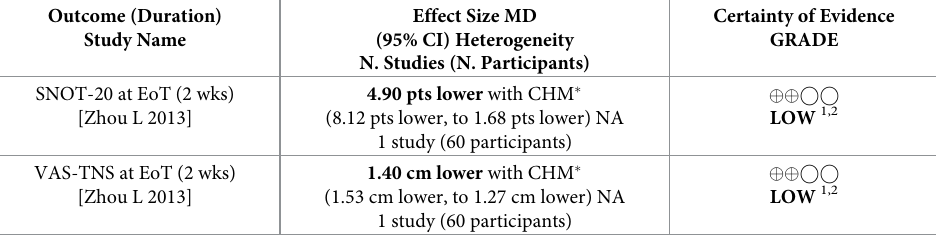
Table 3. GRADE for oral Chinese herbal medicine versus placebo for chronic